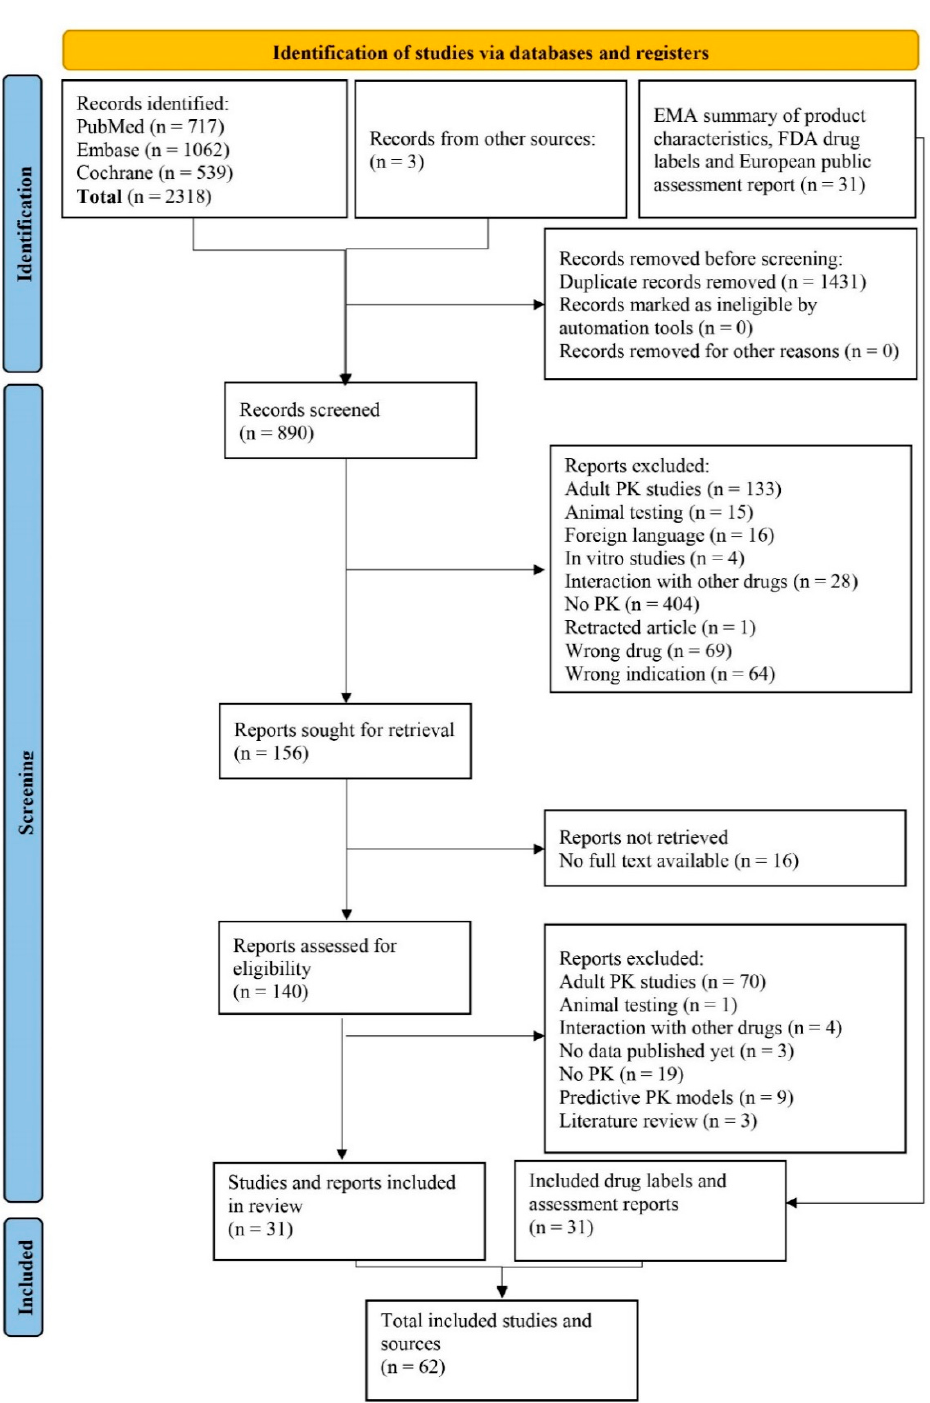
Figure A1. Flowchart of literature searches performed in this review that is based on preferred reporting items for systematic reviews and meta-analyses (PRISMA).